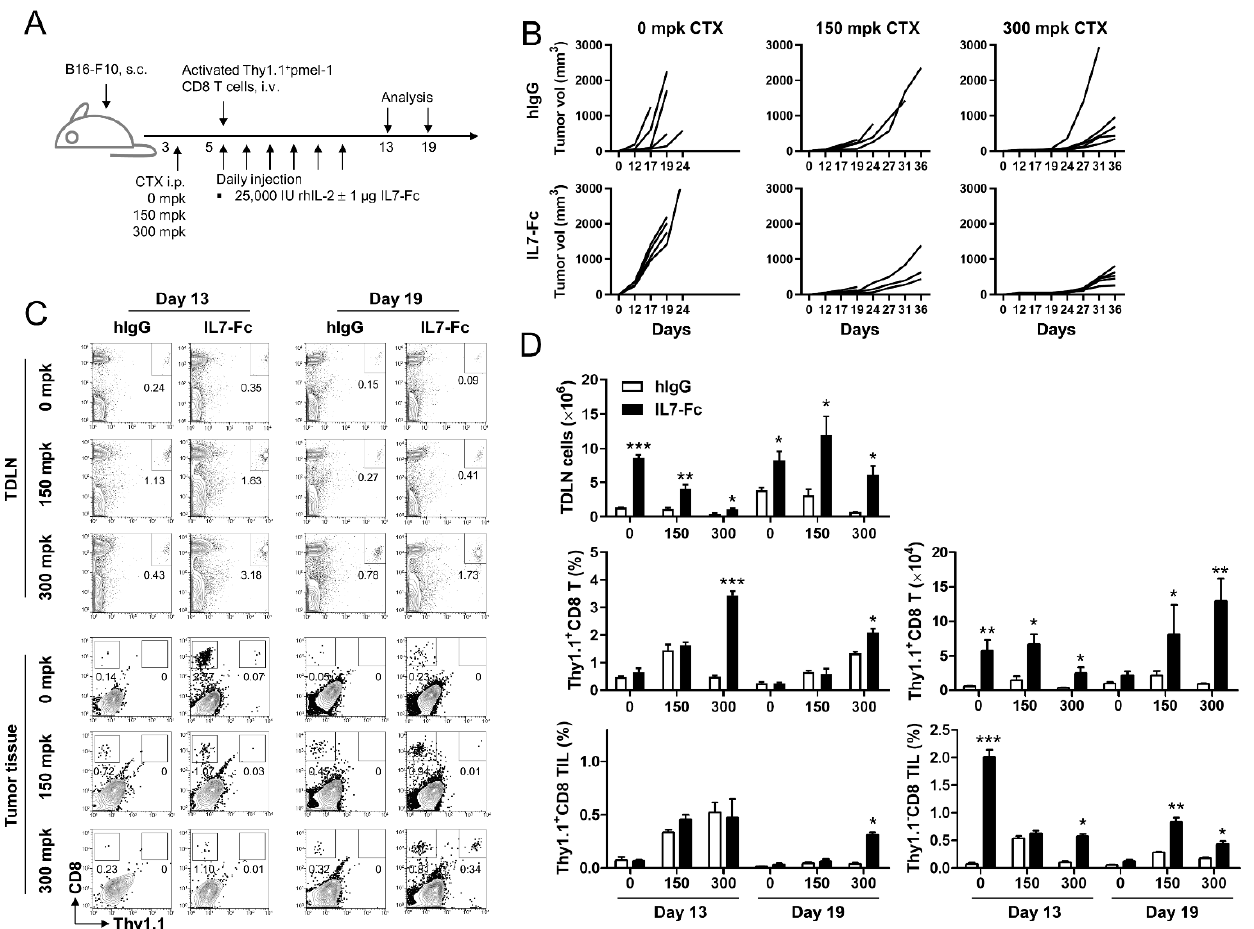
Figure 1. Anti-tumor effects of IL7-Fc in non-lymphopenic and lymphopenic conditions. ( A ) C57BL/6 mice were subcuta- neously implanted with 2 × 10 5 B16-F10 melanoma cells in their backs. Mice were i.p. injected with the indicated dose of CTX to induce prior lymphodepletion on day 3. Activated pmel-1 Thy1.1 + CD8 + T cells were prepared by isolating CD8 + T cells from Thy1.1 + pmel-1 Tg mice and stimulating them with 5 μ g/mL of human gp100 peptide in the presence of 5% CD8-depleted splenocytes for 2 days, and transferred into mice on day 5 via the i.v. route. All mice received 25,000 IU of rhIL-2 daily for 6 days. Human IgG (hIgG) or IL7-Fc was also injected daily into mice for 6 days. ( B ) The growth rate of B16-F10 melanoma. ( C ) Flow cytometric analysis of tumor-draining lymph nodes (TDLNs) and tumor tissues. Single cell suspensions were prepared from inguinal TDLNs and tumor tissues on days 13 and 19, and stained with anti-CD8-PE-Cy5 and anti-Thy1.1-FITC. All samples were further stained with propidium iodide (PI) and subsequently analyzed using FACSCalbur (BD Bioscience). Live cells were gated and plotted as the indicated markers. ( D ) Absolute numbers of TDLN cells were calculated using ADAM-MC2 (Nanoentek, Seoul, Korea). Absolute numbers of Thy1.1 + CD8 + T cells were calcu- lated from TDLN cell numbers and the percentages of Thy1.1 + CD8 + T cells. Percentages of transferred pmel-1 Thy1.1 + CD8 + T cells and endogenous Thy1.1 − CD8 + T cells in tumor tissues were calculated from ( C ). CTX; cyclophosphamide, mpk; mg per Kg. Data are from three ( B ) or two ( C , D ) independent experiments with 5 ( B ) or 3 ( C , D ) mice per experiment. Student's t-test was performed in D, and the results are expressed as mean ± SD (* p < 0.05; ** p < 0.01; *** p < 0.005).